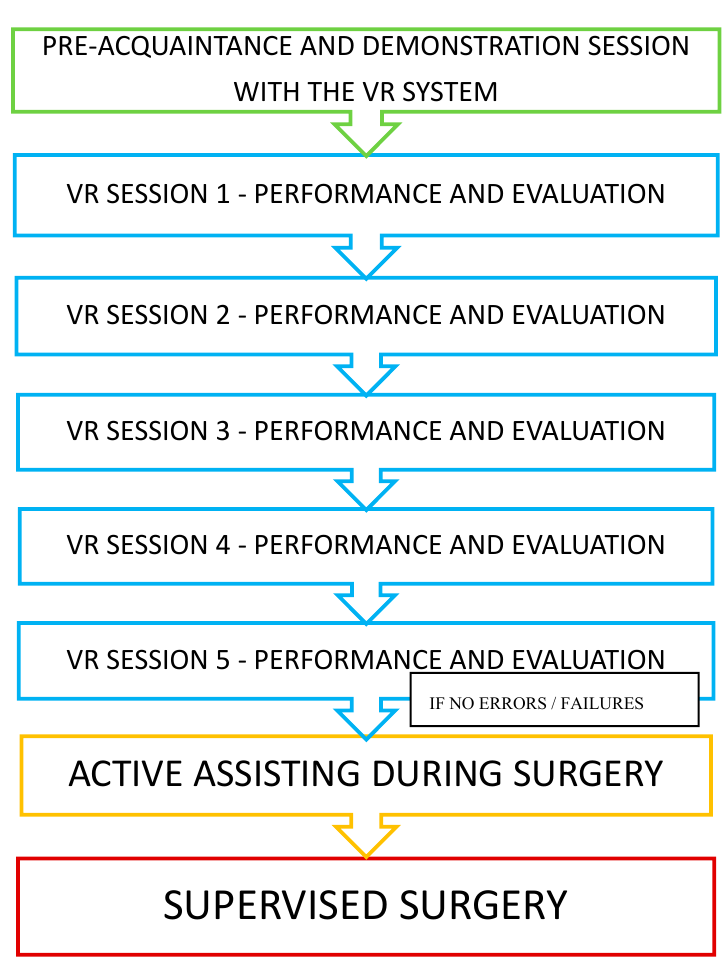
Figure 1. Study design.